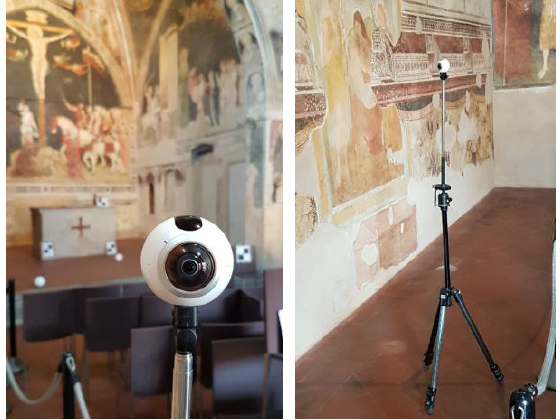
Figure. 6. Image acquisition can be carried out by placing the camera on a tripod; the camera can be pointed to any direction.